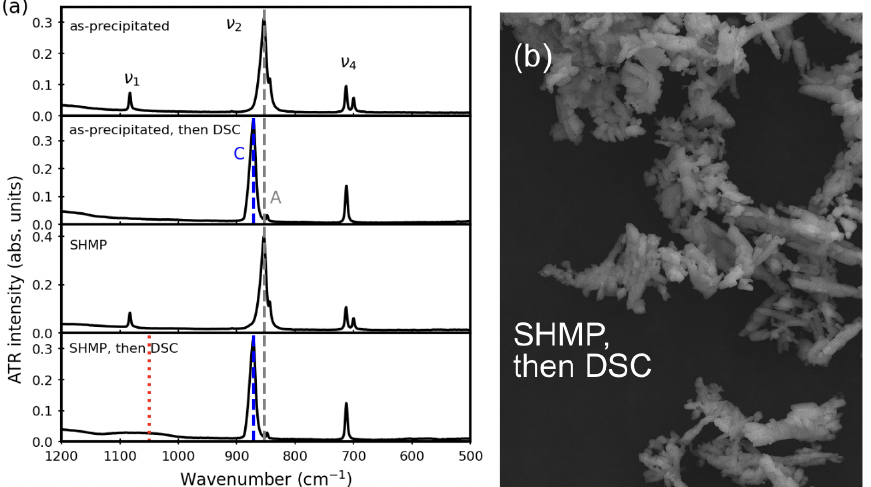
Figure 6. ( a ) Representative ATR-FTIR spectra show that after DSC measurements, both the as- precipitated and SHMP-treated powders convert entirely to calcite (no ν 1 peak, and only one ν 4 peak). The grey vertical line (858 cm − 1 , labeled A) corresponds to the aragonite ν 2 peak, while the blue vertical line (875 cm − 1 , labeled C) shows the calcite ν 2 peak. The SHMP-treated sample (10 mM) also shows a very broad peak in the 1000–1200 cm − 1 region (indicated by the red-vertical- dotted line), suggestive of a small phosphate secondary phase [15]. ( b ) Representative SEM image of SHMP-treated aragonite after DSC measurement, covering a width of 50 µ